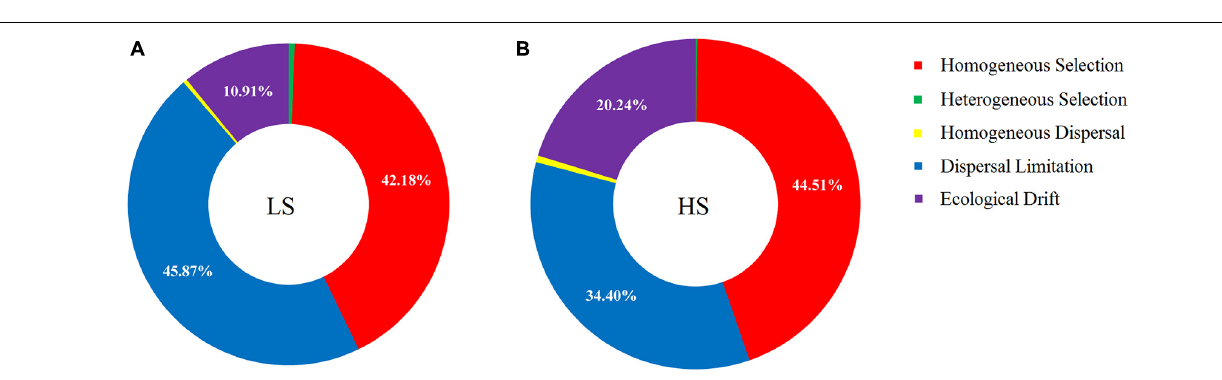
FIGURE 6 | Ecological process analyses on shrimp intestine bacterial assembly in the LS and HS groups. (A) Approximately half of the observed variation was attributed to dispersal limitation and homogeneous selection processes in the LS group, while the drift process contributed to only 10.91% variation. (B) Over one-third of the variation was attributed to homogeneous selection and dispersal limitation processes in the HS group, while the ecological drift process contributed to 20.24% of the observed